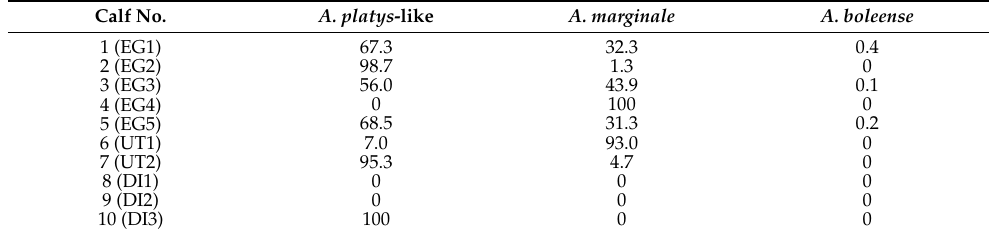
Table 2. The percentage of 16S rRNA sequences of each Anaplasma spp. identified. Calf No.